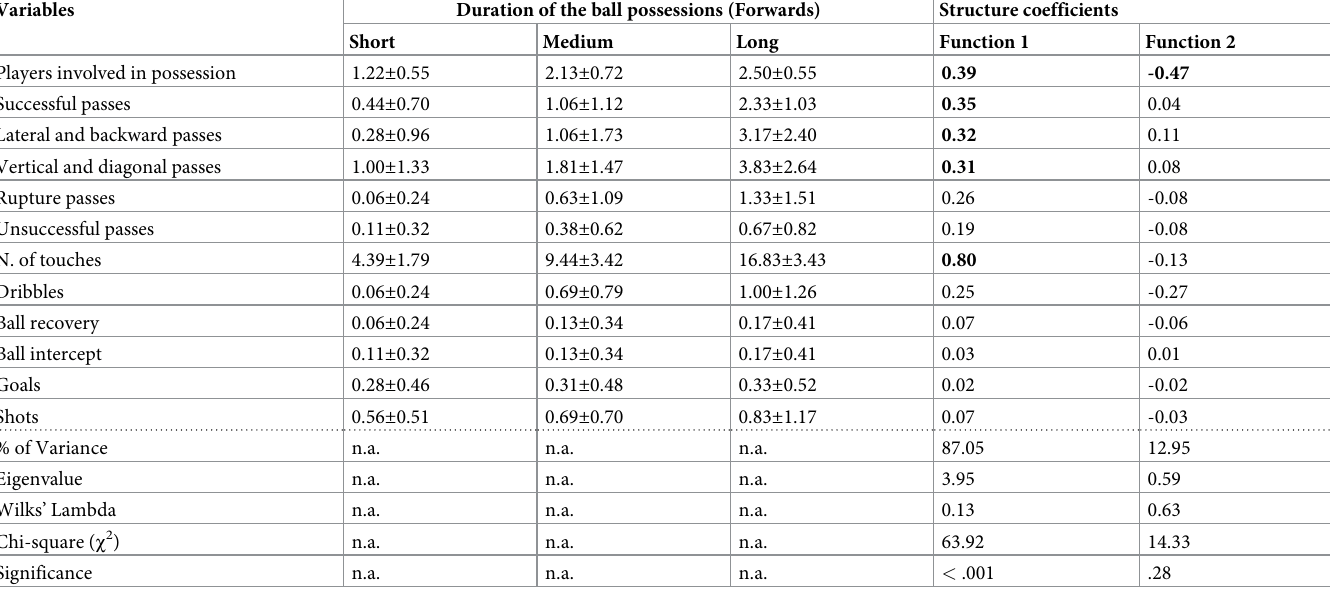
Table 4. Means ( ± SD), discriminant function details and structure coefficients for the three clusters according to the forwards game